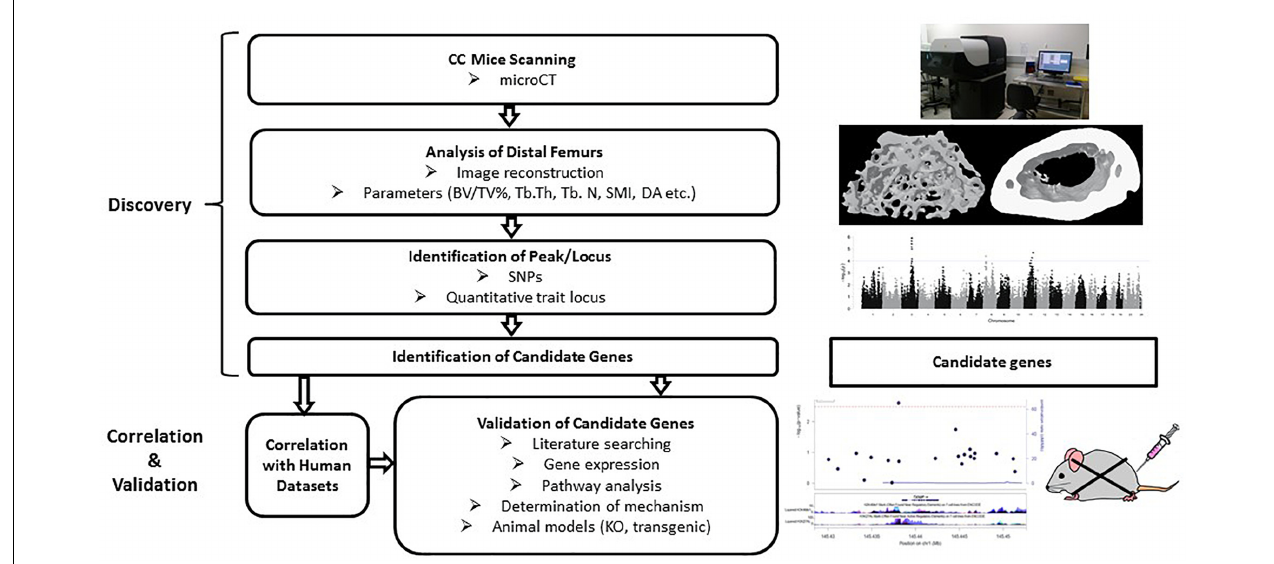
FIGURE 5 | Workflow of the collaborative cross mice screening. The CC study starts with searching for associations among strains and identification of candidate genes within the identified locus, followed by validation of those candidate genes for association with the phenotype. Correlation with human datasets add confidence for the SNPs/genes. Validation can be done by gene expression, pathway analysis and looking at the functions of selected genes through transgenic or knockout mouse models.